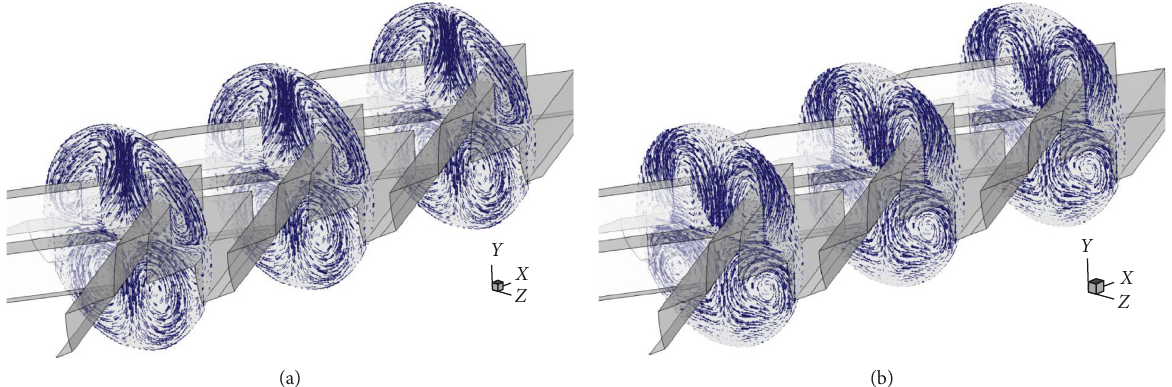
Figure 5: Tangential velocity vector in transverse planes of the heat exchanger tube inserted with the V-wavy surface at α for (a) V-Downstream and (b) V-Upstream.